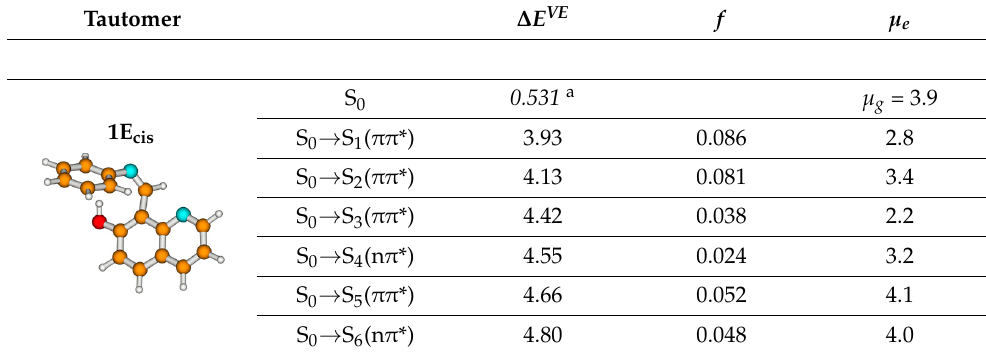
Table 1. Cont. Tautomer